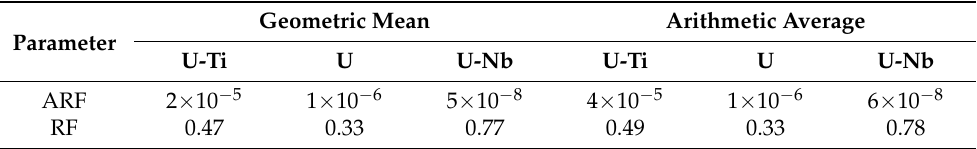
Table 11. Results from Clark et al. [22]. “Reprinted with permission from Ref. [Characterization of Respirable Uranium Aerosols from Various Uranium Alloys in Fire Events]. 2015, Clark, D.K.” Geometric Mean Arithmetic Average Parameter U-Ti U